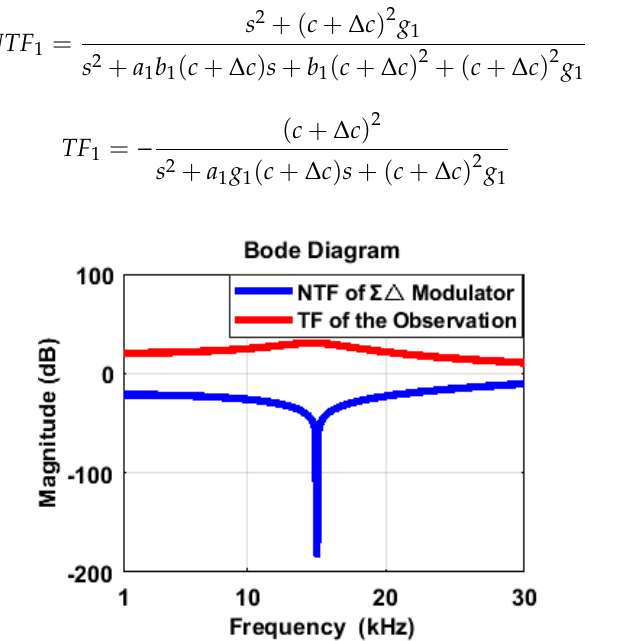
Figure 5. Spectrums of the Σ∆ modulator’s noise transfer function (NTF) and the signal observation’s transfer function (TF).